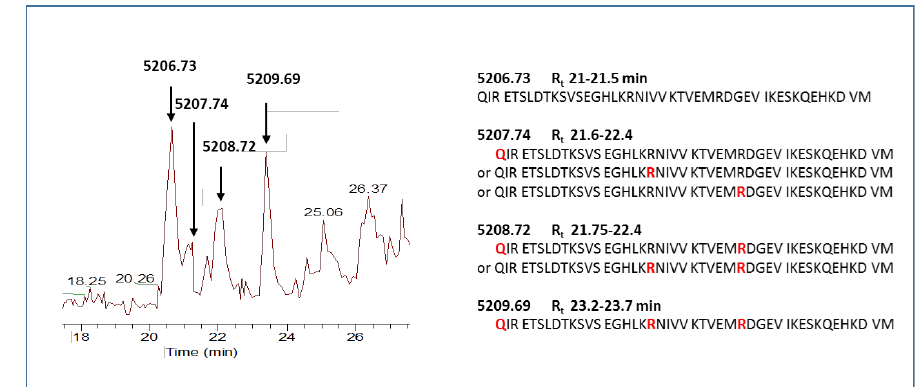
Figure 1. Enlarged view of the LC-Orbitrap Elite MS eXtracted Ion Current (XIC) plot of the glial fibrillary acidic protein (GFAP) fragment 388–432 5206.73 Da, ([M+H] + ) and its mono- and poly-citrullinated forms. The relative amino acid sequences with the position of the PTMs (Q deamidation , R citrullination , in red) are also reported.